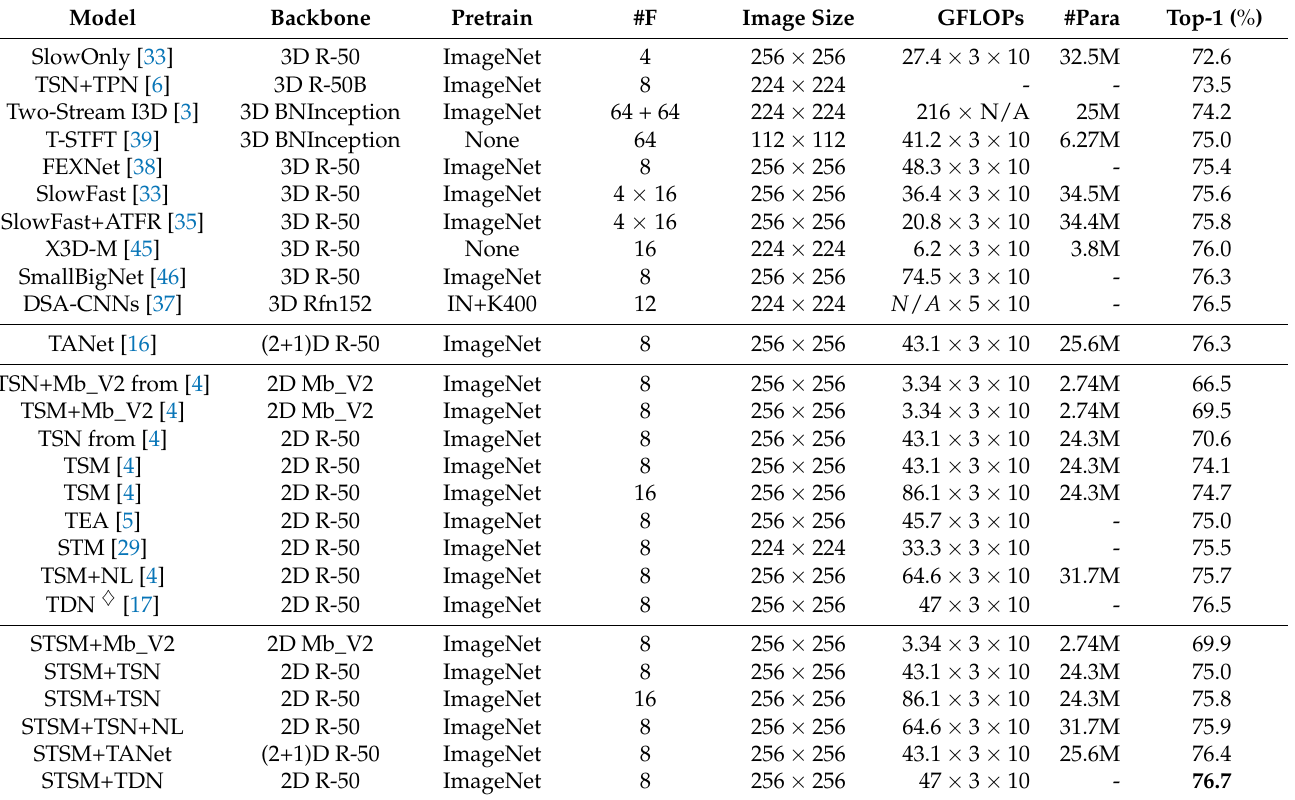
Table 6. The comparison between our method and the state-of-the-art method on the validation set of Kinetics-400. ♦ means the result obtained by directly using the author’s GitHub. The input streams of Two-Stream I3D and DSA-CNNs are RGB and FLOW. IN+K400 means